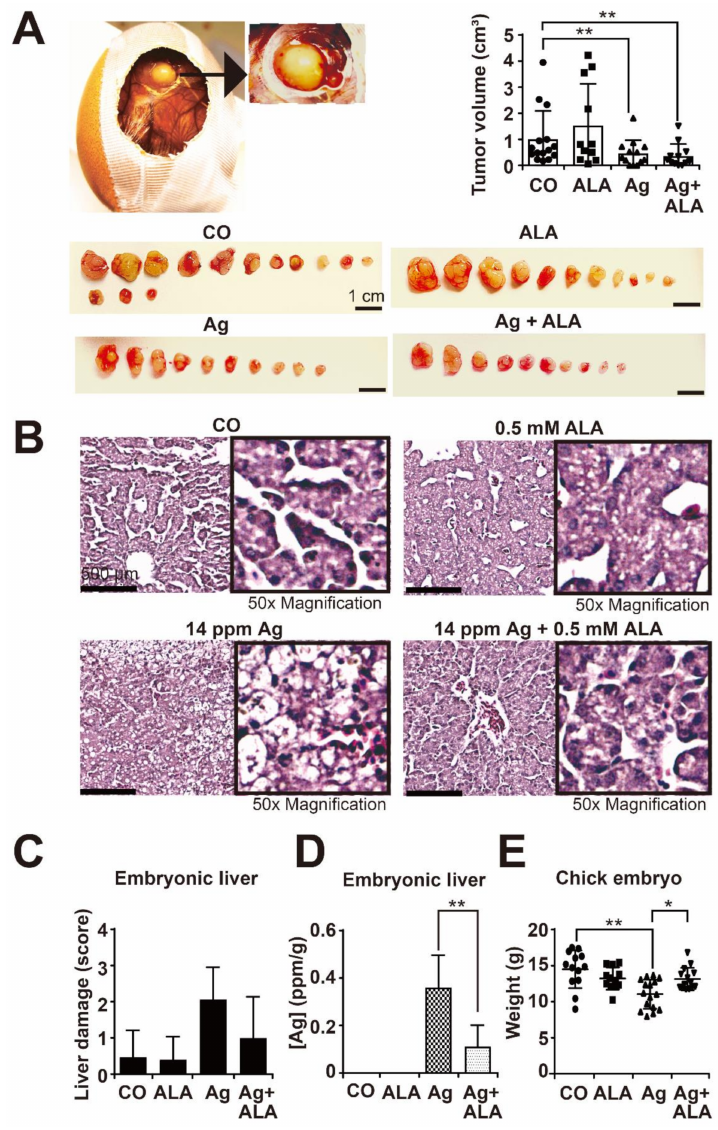
Figure 7. α -Lipoic acid prevents AgNP-induced liver toxicity and embryonal weight loss without affecting the inhibition of PDAC xenograft growth. ( A ) Fertilized chicken eggs were prepared for xenotransplantation as described in the Materials and Methods, and on day 9 of development, 10 6 MIA-PaCa2 cells in 50 µ L Matrigel TM were transplanted onto the CAM. A representative image of a tumor xenograft at day 18 of chick development and a magnification thereof (black arrow) is shown on the upper left. On day 12 of embryonal development, 400 µ L H 2 O bidest (CO), 400 µ L of a 14 ppm AgNP solution, 400 µ L of a 0.5 mM α -lipoic acid (ALA) solution or 400 µ L of a complex of 14 ppm AgNPs with 0.5 mM ALA was separately dropped onto the CAM vessels that supplied the